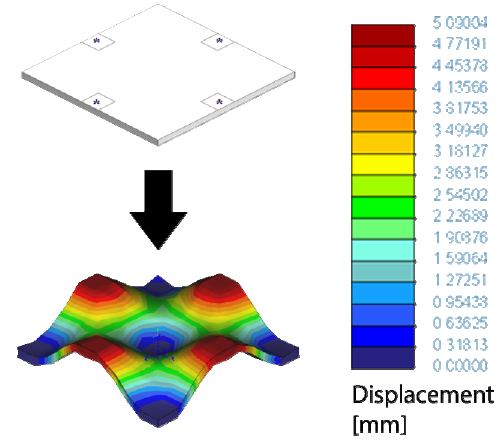
Figure 4. Deformation of a plate with the corners and the center fixed and a displacement imposed in 4 different areas in the opposite face (displacement [mm])